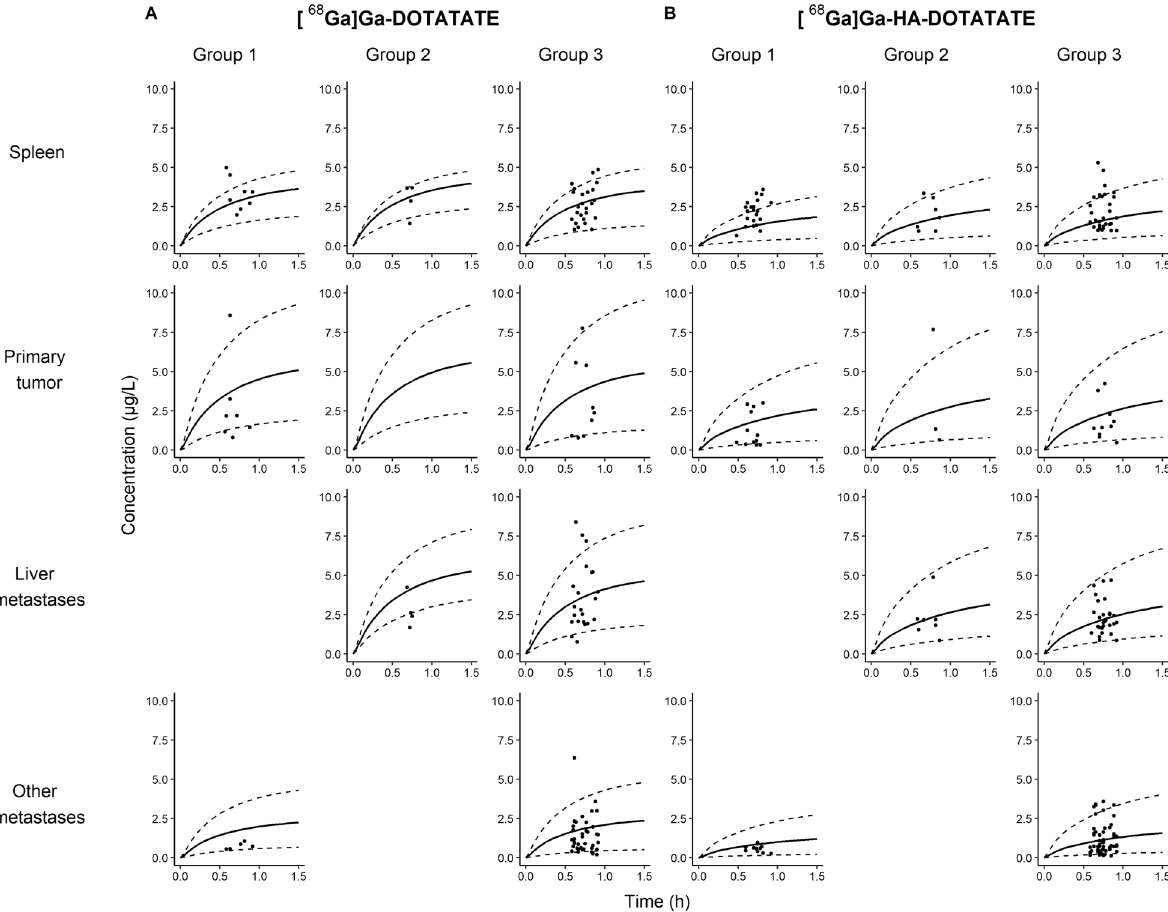
Fig. 2 PBPK model prediction results per group (solid lines) for [ 68 Ga]Ga‑DOTATATE ( A ) and [ 68 Ga]Ga‑HA‑DOTATATE ( B ), including minimum and maximum population ranges (dashed lines) that were based on administered peptide amount ranges, SSTR2 variability in organs, tumor blood flow variability and tumor blood volume variability. Missing data in group 2 for [ 68 Ga]Ga‑DOTATATE primary tumor uptake due to resection of the primary tumor for all patients ( n 4) =